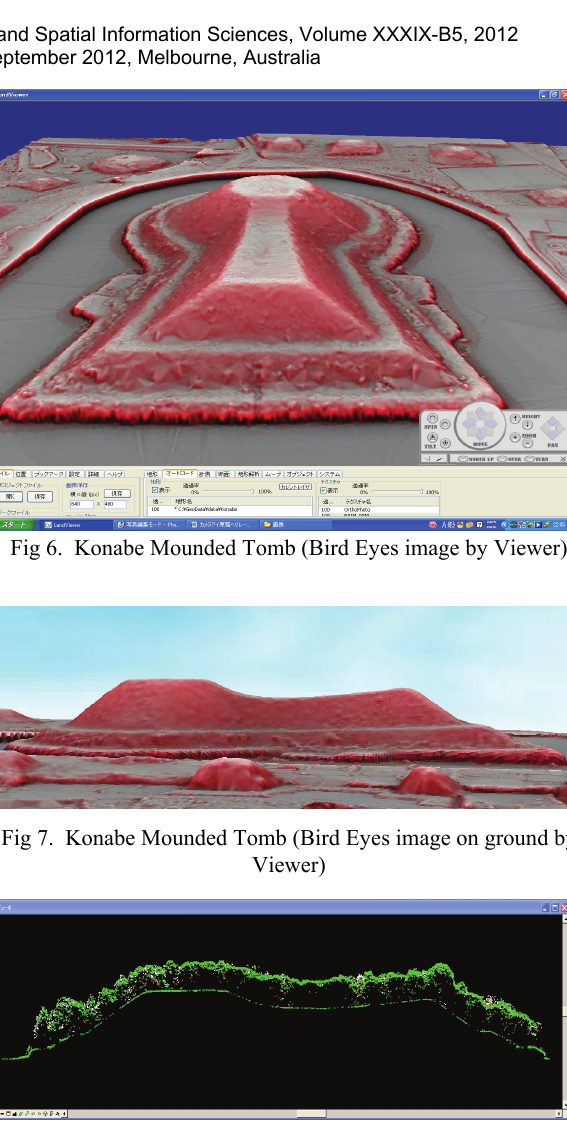
Fig8. Vegetatin structure in Konabe Mounded